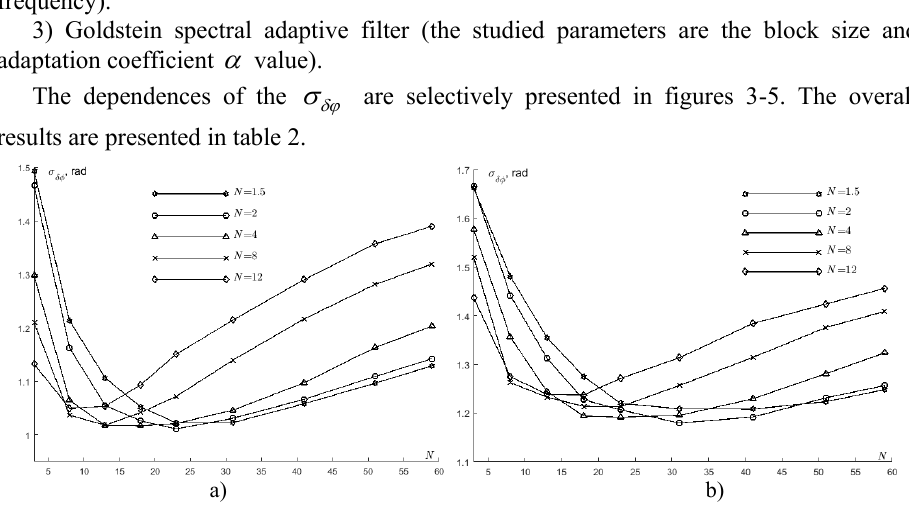
 dependencies on the window size for the averaging algorithm: a) scene N 1; b) scene N 2. Fig. 3. 